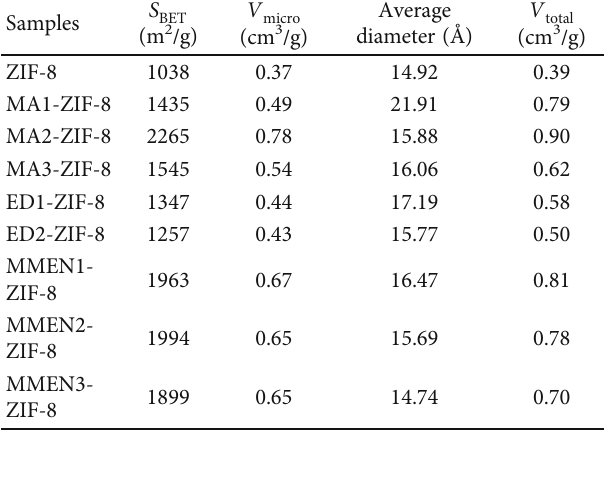
Table 1: Texture properties of the amine-modi fi ed ZIF-8 samples. Samples